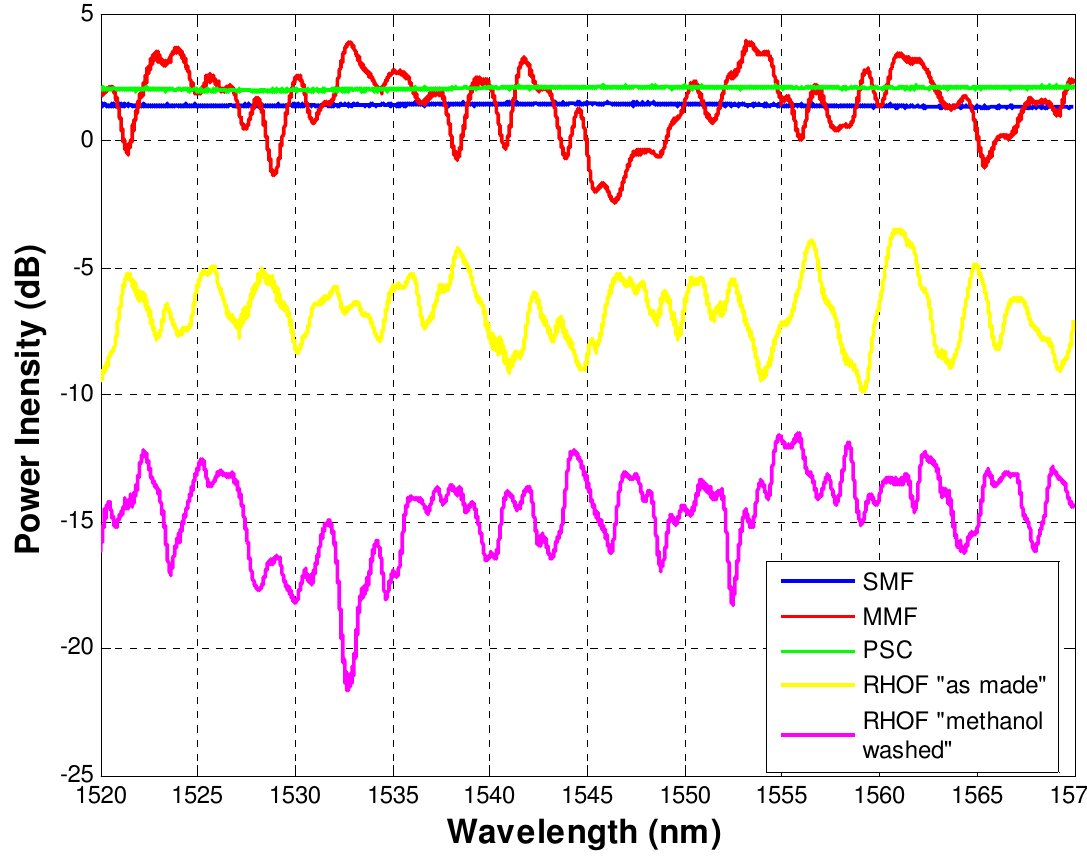
Figure 4. Transmitted optical spectra of fiber samples at t o , SMF (blue), MMF (red), PSC (green), RHOF “as made” (yellow), RHOF “ methanol washed”